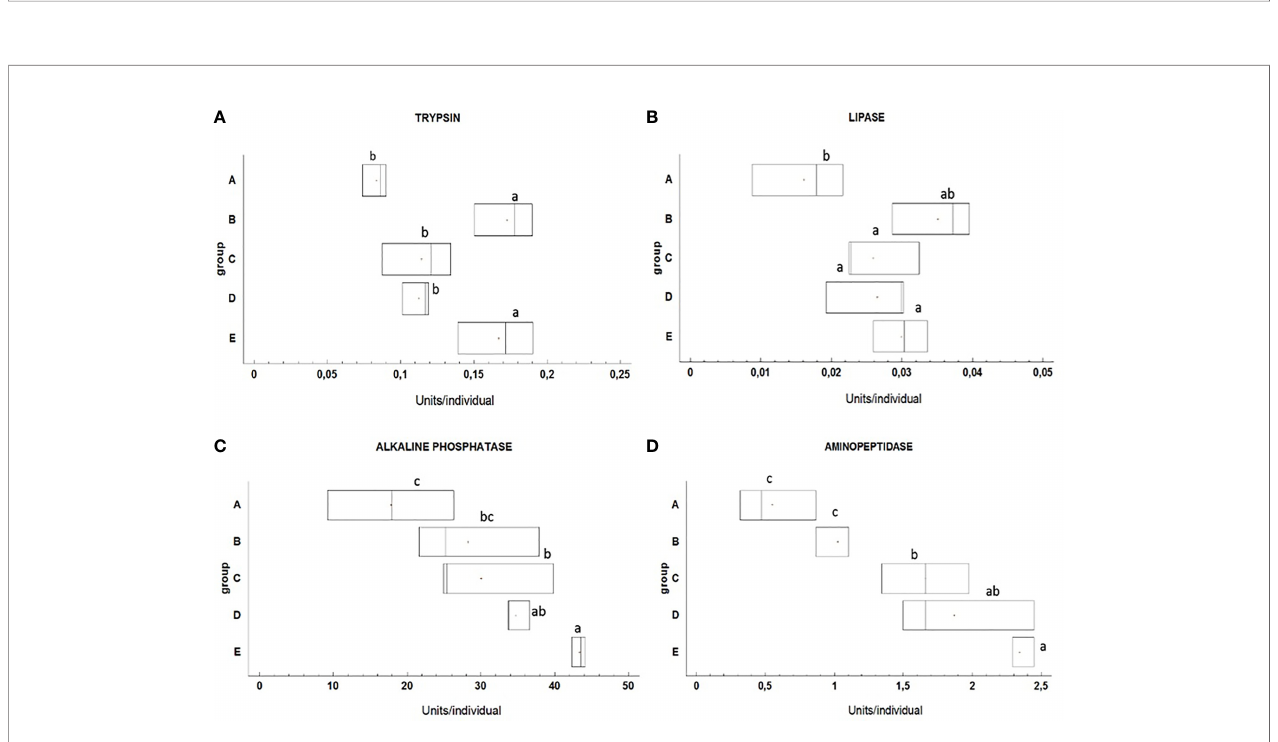
FIGURE 3 | Principal component analysis (PCA) correlation biplot based on the fi rst two principal components (PC1 and PC2) generated from gene expression of different digestive enzymes and indicators of intestinal maturation in the different experimental